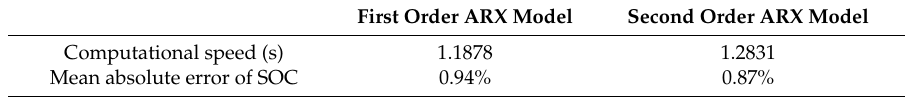
Table 3. Comparison of first order and second order ARX battery models without uncertainties.